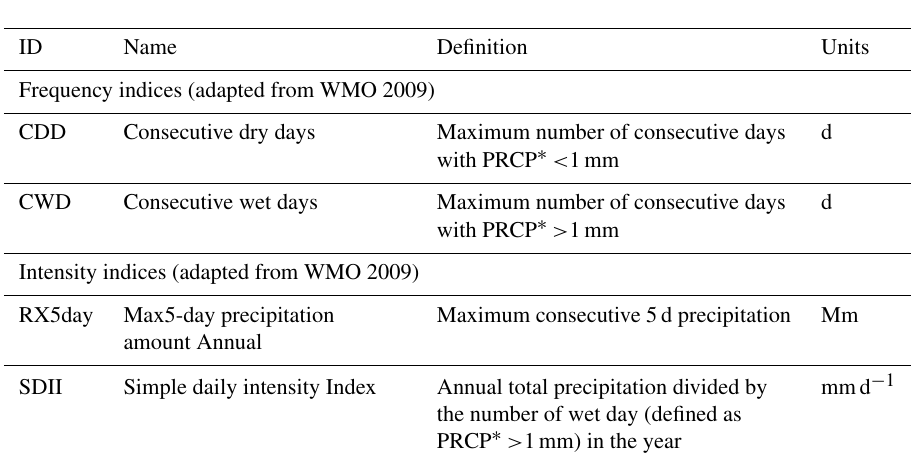
Table 2. Selected indices and their